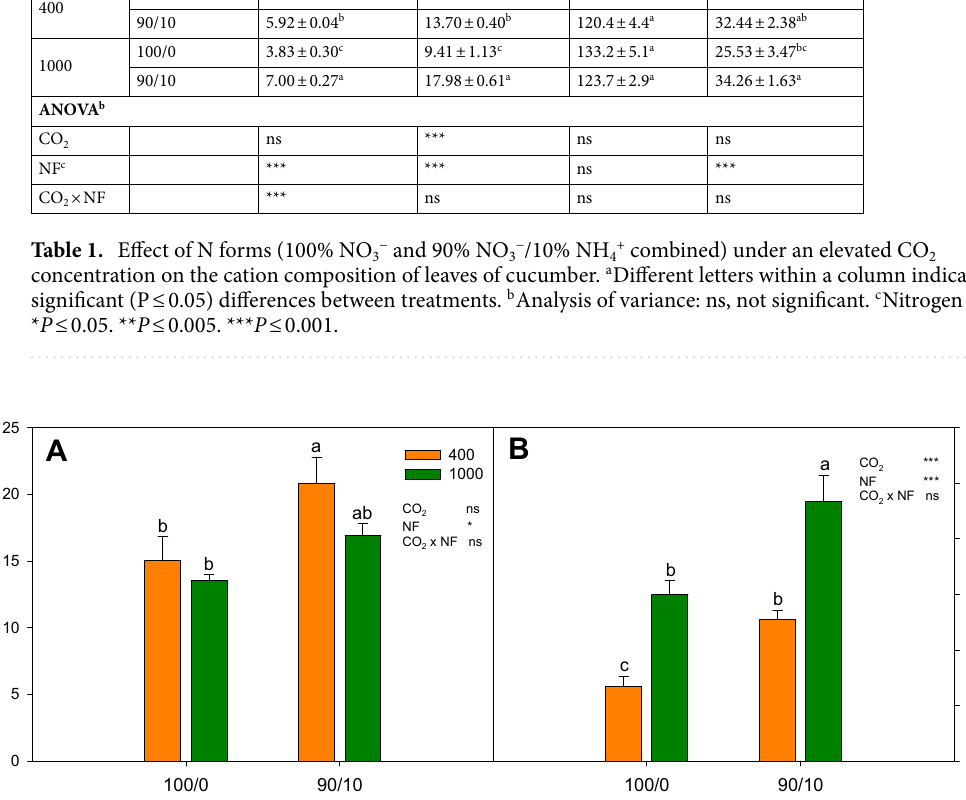
Figure 2. Effect of N forms (100% NO 3 − and 90% NO 3 − /10% NH 4 + combined) under an elevated CO 2 concentration on leaves of cucumber: ( A ) soluble sugars; and ( B ) starch. Data are means ± SE of six plants. Different letters indicate significant ( P ≤ 0.05) differences between